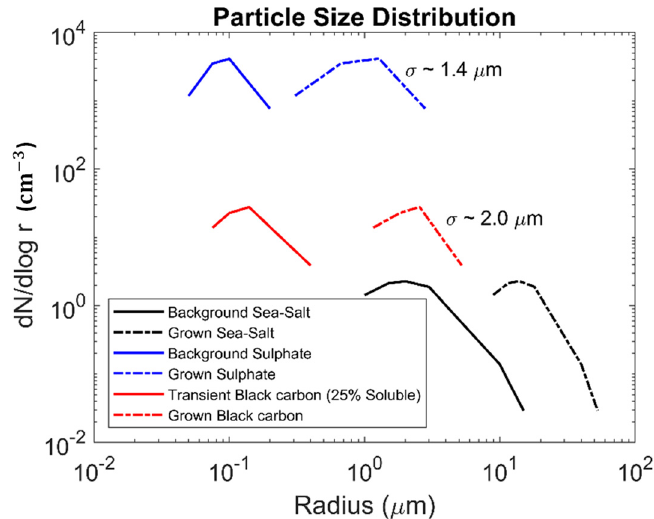
Figure 6. Resultant cloud droplet spectra near the cloud base grown from sulphate (fully soluble), black carbon (25% solubility) and natural sea salt aerosol (fully soluble). The spectra on the left (solid lines) pertain to dry aerosol size distributions; the background sulphate and sea salt modes were sourced from Gumber et al. (2020). The vehicle generated black carbon mode was derived experimentally (Kumar et al. 2019) and appropriately diluted. The spectra on the right are deliquesced droplets near the cloud base. The spectral width of each mode is also indicated.